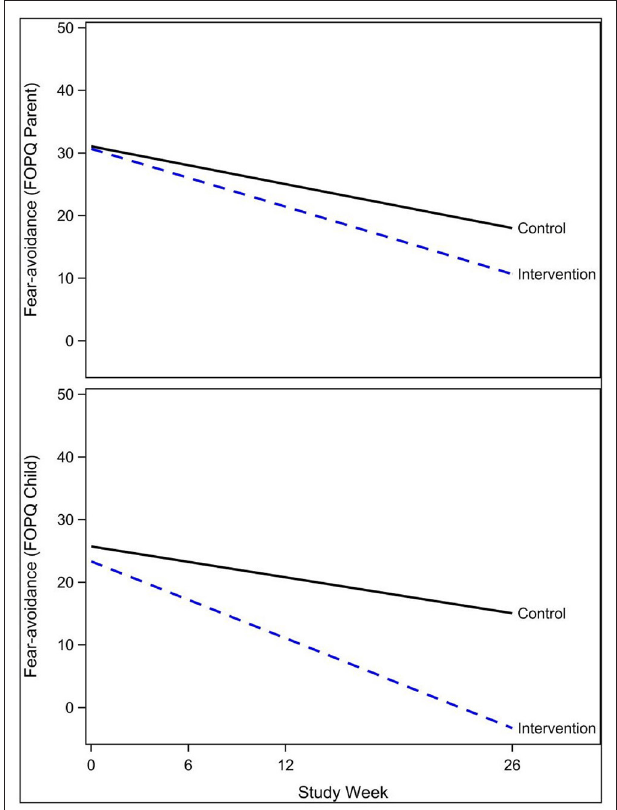
FIGURE 4 | Effect of the Sub-Threshold Exercise Program (STEP) on fear-avoidance in youth, Seattle WA 2016–17.